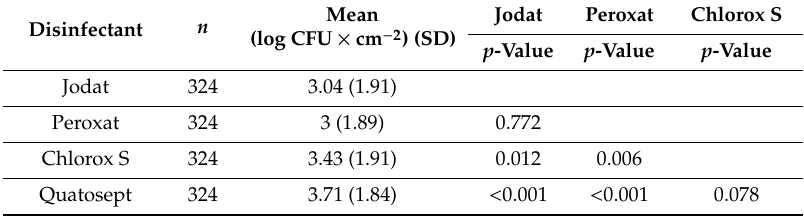
Table 4. Reduction of bacteria number reisolated from biofilm for the investigated